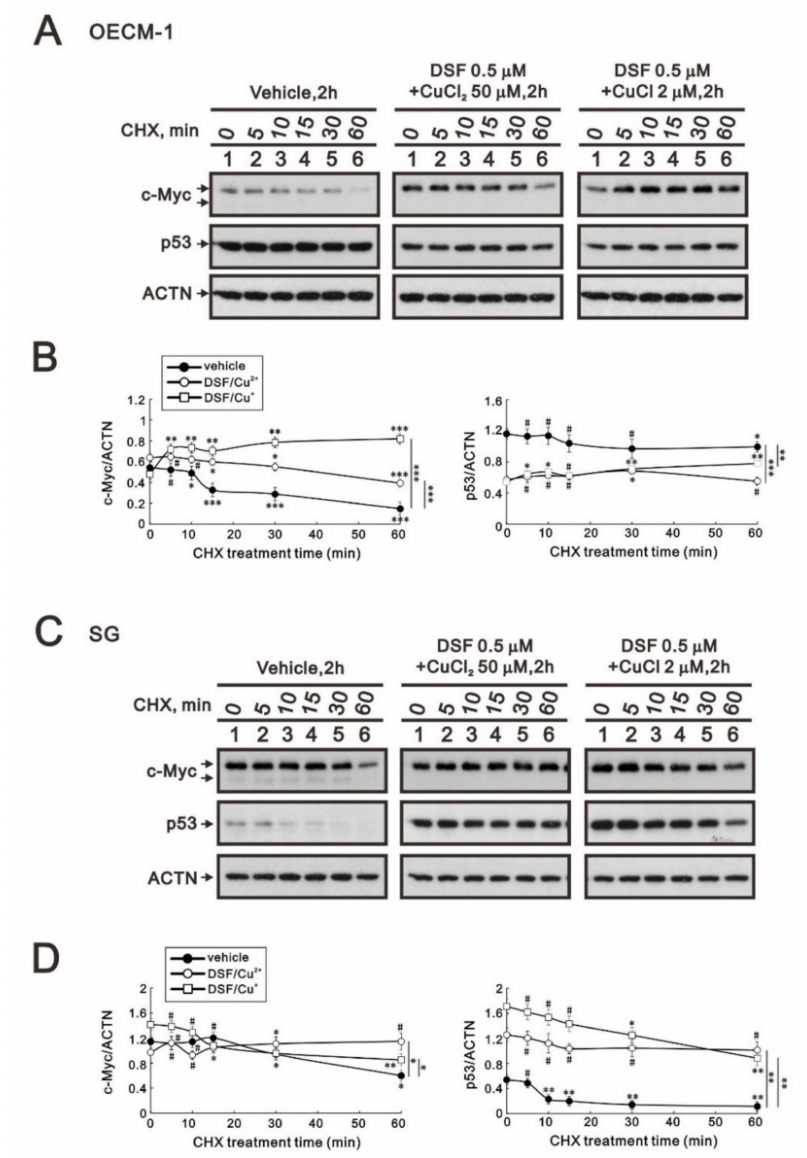
Figure 3. The effects of DSF, copper ions, and DSF/copper complexes on the stability of the c-Myc and p53 proteins in OECM-1 and SG cells. OECM-1 ( A ) and SG ( C ) cells were treated with vehicle, 50 µ M of CuCl 2 plus 0.5 µ M of DSF, or 2 µ M of CuCl plus 0.5 µ M of DSF for 2 h, accompanied by 50 mg/mL CHX for 0, 5, 10, 15, 30, and 60 min. The cell lysates were subjected to Western blot analysis using antibodies against c-Myc and p53 proteins. ACTN was a loading protein control. The protein bands were quantified through pixel density scanning and evaluated using ImageJ, version 1.44a (http://imagej.nih.gov/ij/) (accessed on 1 May 2022). The ratios of c-Myc/ACTN and p53/ACTN were plotted in OECM-1 ( B ) and SG ( D ) cells. The results are representative of three independent experiments. The quantified protein bands were compared in cells treated with indicated time of CHX to the 0 h. # p > 0.05, * p < 0.05, ** p < 0.01, and *** p <